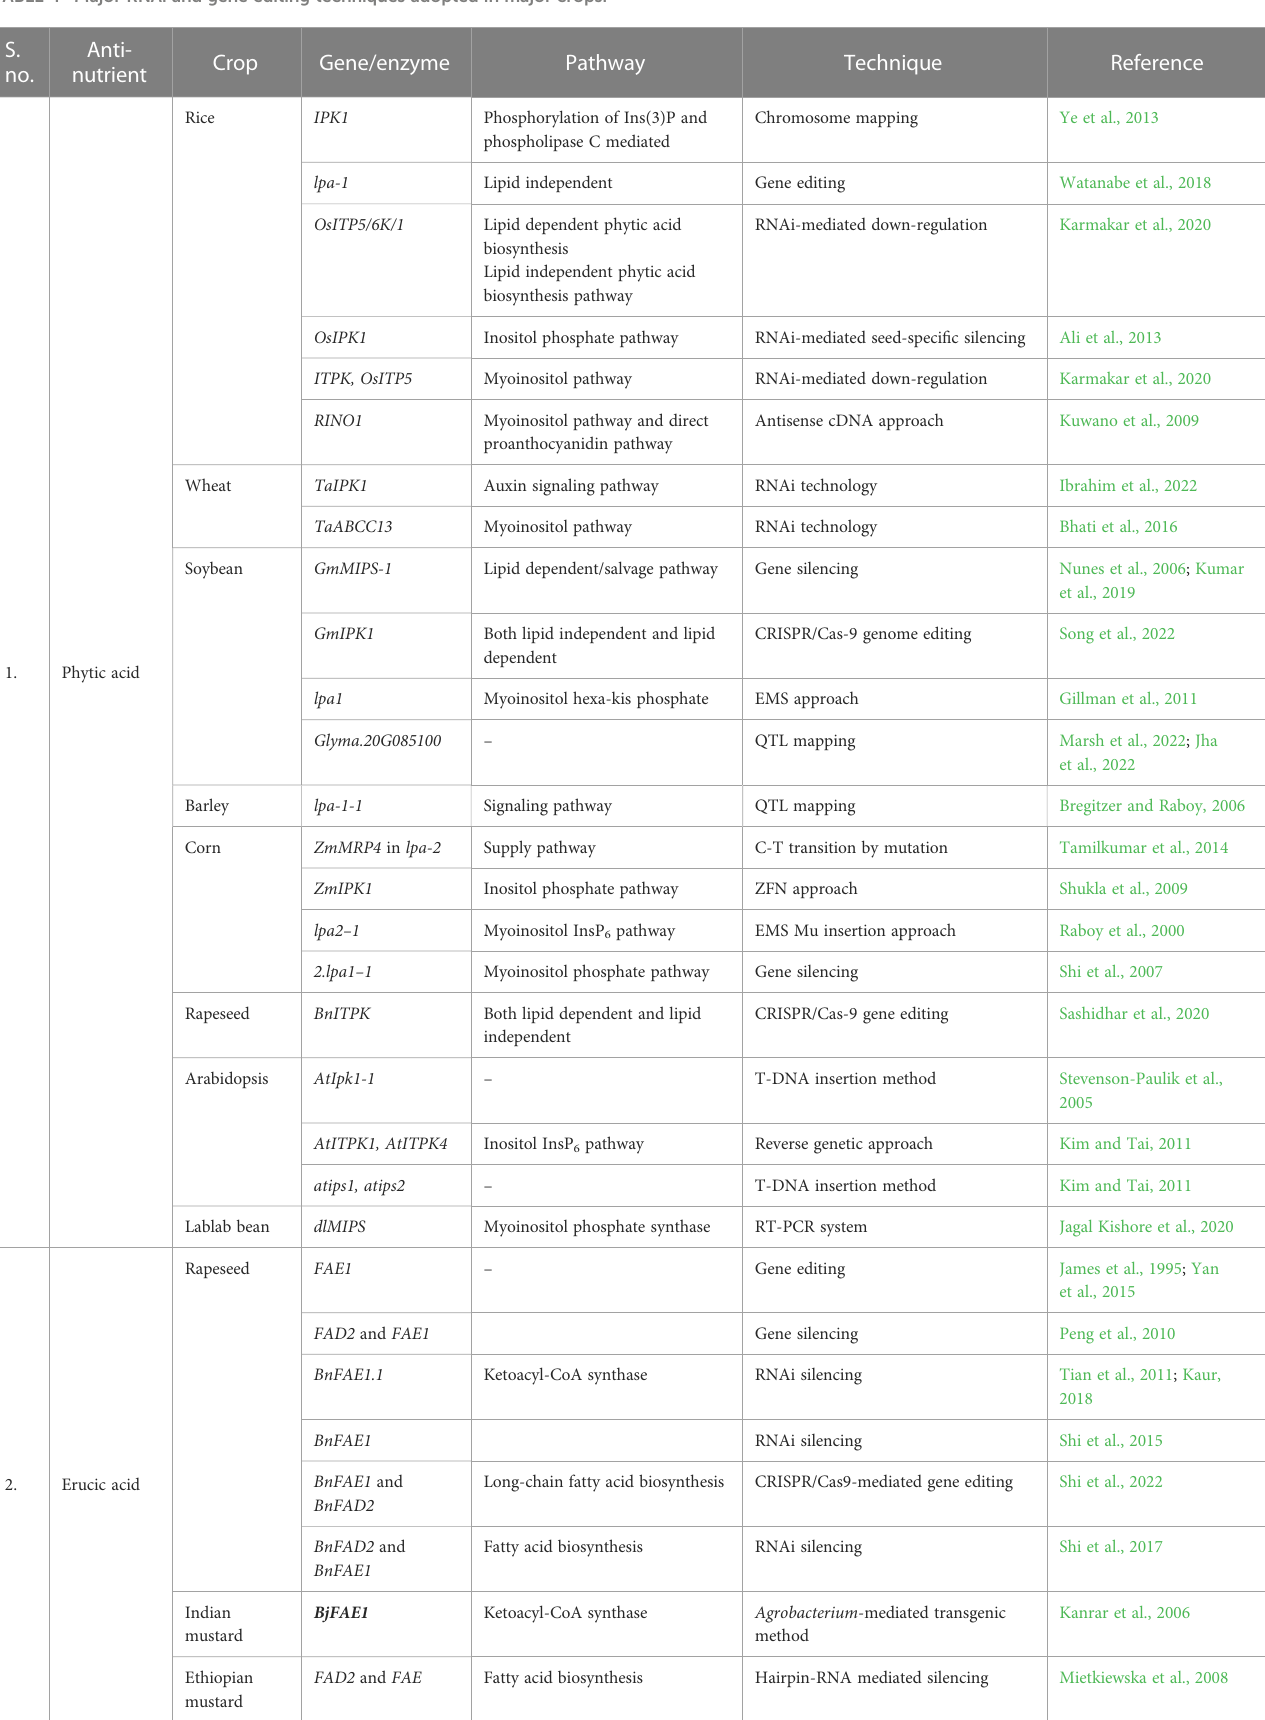
TABLE 4 Major RNAi and gene editing techniques adopted in major crops. S.